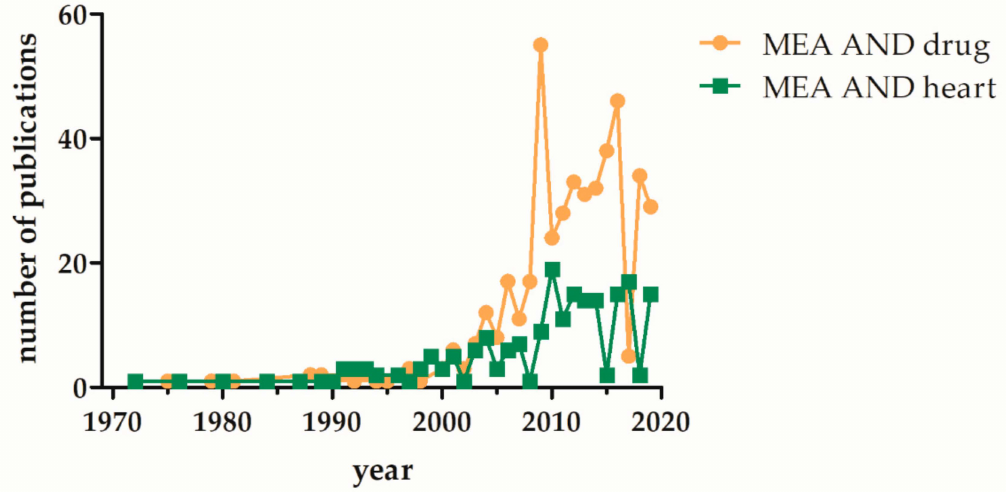
Figure 3. Increase of PubMed listed publications involving MEA based analysis of “heart” or “drugs” over the last five decades. The terms (multielectrode array and drug) or (microelectrode array and drug) and (multielectrode array and heart) or (microelectrode array and heart) were used for the PubMed search (date: Sept